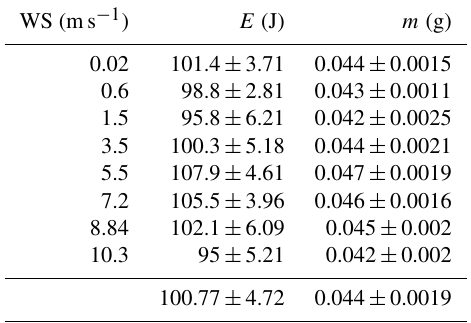
Table 1. Mean and standard deviation of mass ( m ) and energy loss ( E ) per droplet from the hotplate measured using the DEID method- ology for eight different wind speeds (WS) for 0.04g water droplets. WS (ms − 1 )